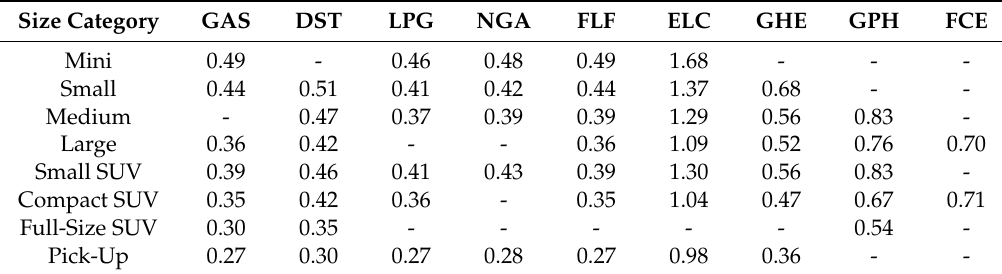
Table 5. Average e ffi ciency values (in billion vehicle-kilometers (Bvkm/PJ) for all car and light truck size